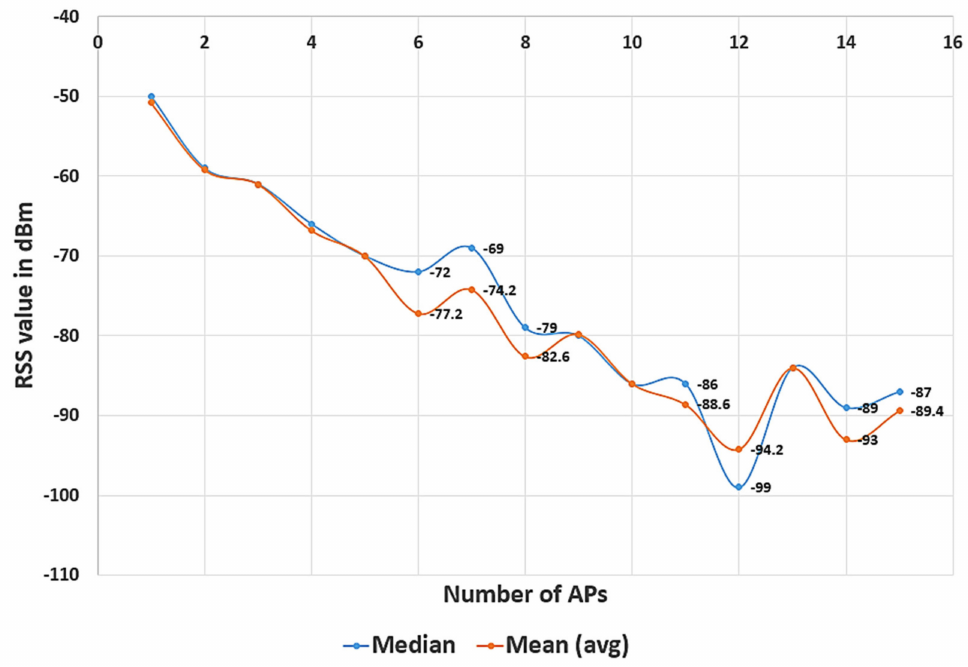
Figure 4. Comparison of mean and median RSS at the